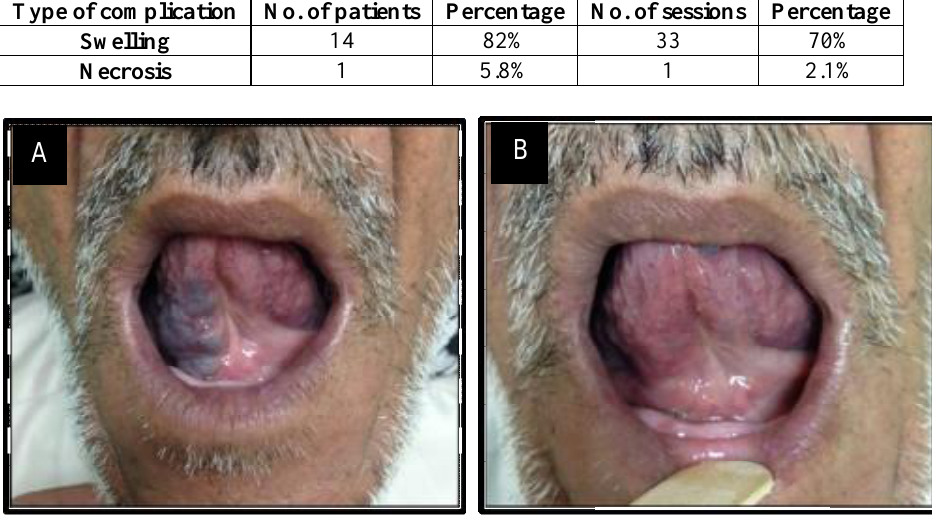
Fig. 4: Patient with venous malformation treated by polidocanol foam sclerotherapy, A before treatment, B after 3 injection sessions.